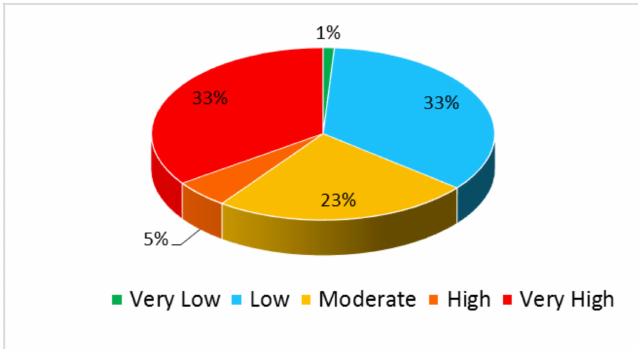
Figure 5. Number of units categorized in each vulnerability class.